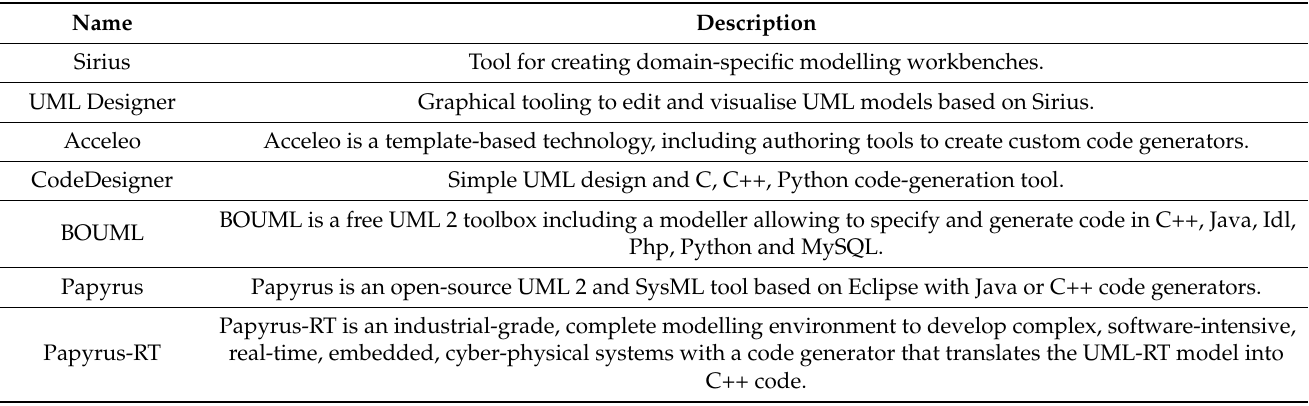
Table 8. Control system modelling tools.